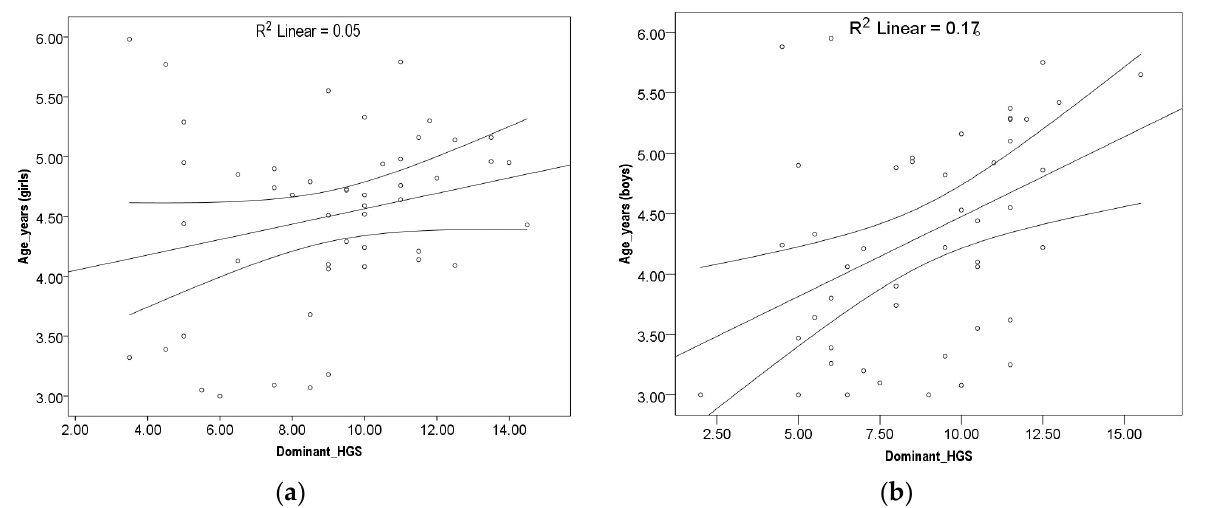
Figure 3. ( a ) Dominant HGS girls. ( b ) Non-dominant HGS boys.